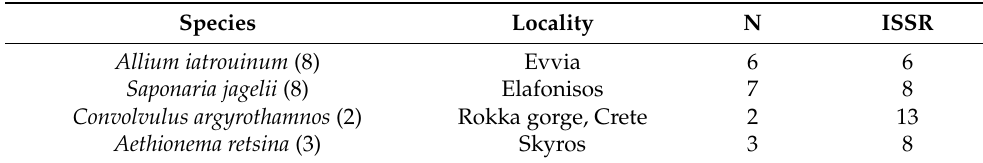
Table 1. Plant species, sampling sites, number of individuals per sampling site, and number of mark- ers that were successfully and repeatedly amplified per species in this study are shown. Individuals sampled from each species under study are given in parentheses. N: number of samples finally used in the analysis. ISSR: inter simple sequence repeats. Species Locality N ISSR Allium iatrouinum (8) Evvia 6 6 Saponaria jagelii (8) Elafonisos 7 8 Convolvulus argyrothamnos (2) Rokka gorge, Crete 2 13 Aethionema retsina (3) Skyros 3